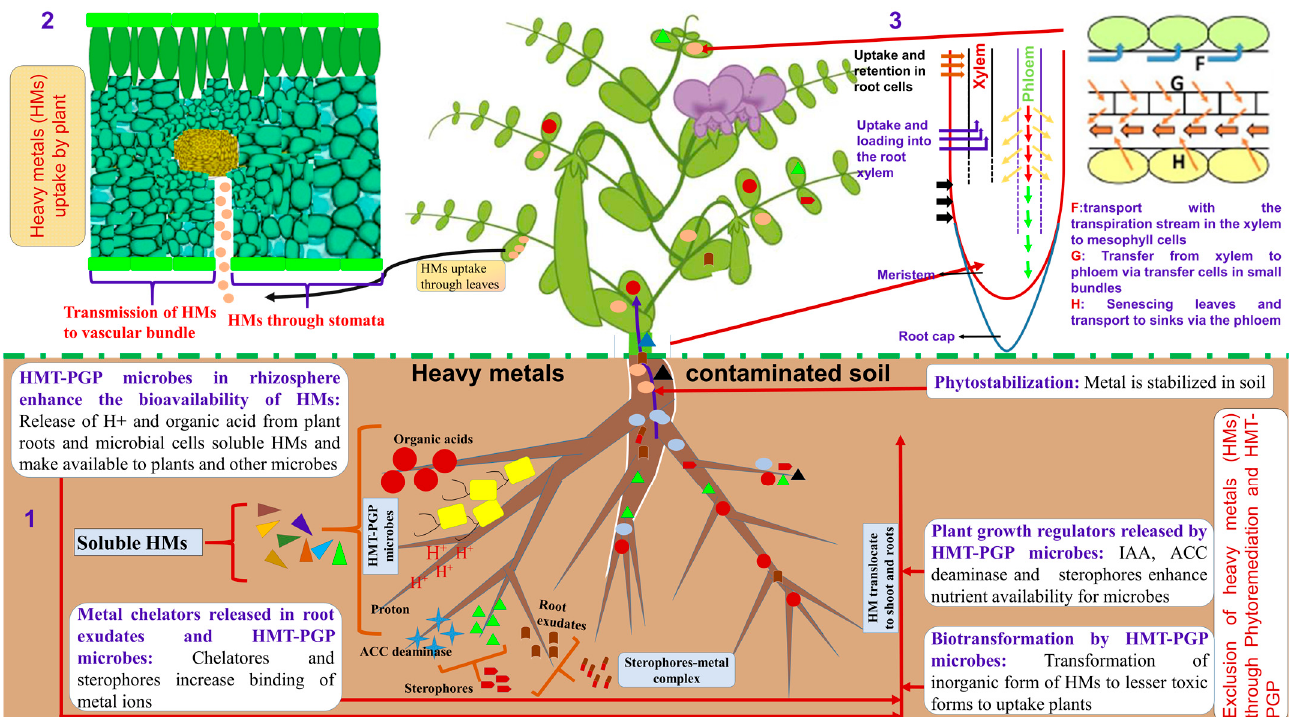
Figure 1 . Schematic representation of the mechanisms involved in plant uptake, transportation, and phytoremediation of HMs: (1) Heavy metal tolerant-plant growth-promoting (HMT-PGP) microbes in ensuring plant survival and growth in contaminated soils; (2) the processes involved in the distribution and redistribution of heavy metals in plants; and (3) and remobilization from senescing leaves and transport to sinks via the